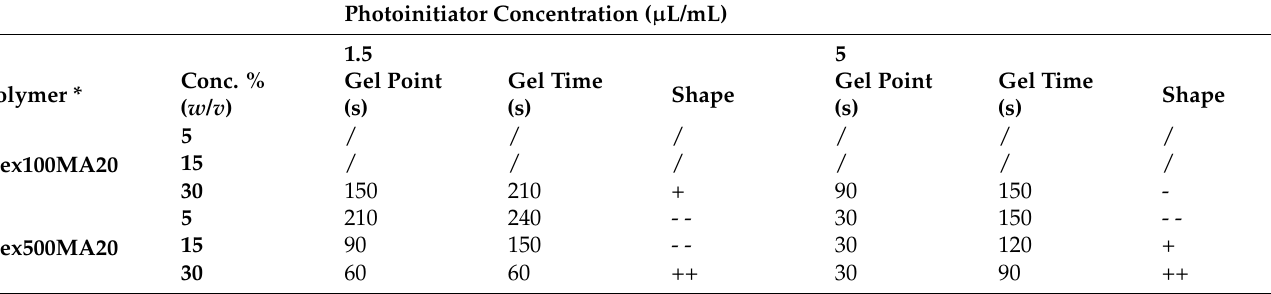
Table 3. Gelation and shape properties of dextran methacrylate were analyzed. Dex100MA20 and Dex500MA20 at 5, 15, and 30% ( w / v ) with 1.5 or 5 µ L/mL of photoinitiator solution. The sol-to- gel transition was characterized using the vial tilting method. The gel point was reached when the solution/gel stopped flowing, and the gelation was considered completed (gel time) when the entire hydrogel could be lifted without any fluid flow. After gelling, the demolded hydrogels were visually inspected and the capacity to maintain the original shape was scored from ++ for very good, + for good, +/- for fair, - for bad, and - - for very bad. The symbol/indicates that no hydrogel formation occurred. Dex100MA20: Dextran 100 kDa with a theoretical methacrylation degree of 20%, Dex500MA20: Dextran 500 kDa with a theoretical methacrylation degree of 20%. * No Dex40MA20 hydrogel was obtained, and the gelation and shape properties could not be